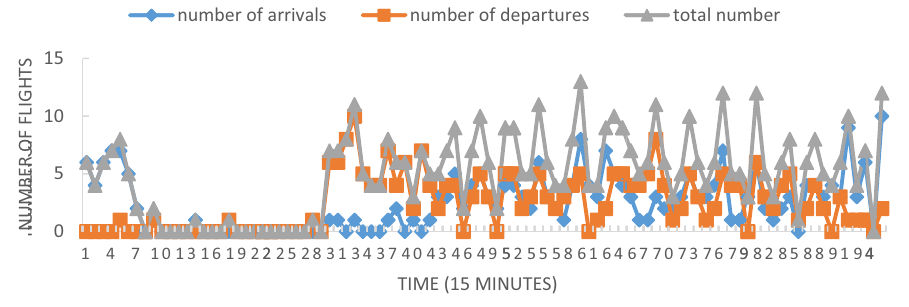
Figure 4: Arrival and departure fl ight slots distribution in every 15 min in the Urumqi airport original fl ight schedule.